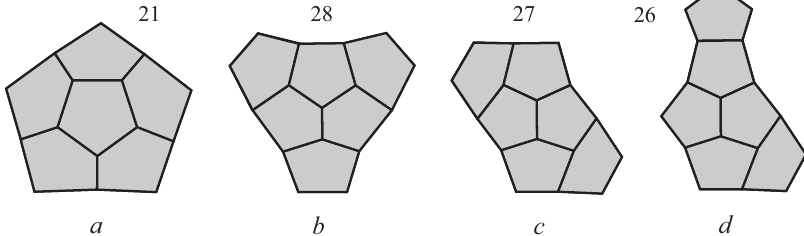
Figure 4. Pentagonal parts of caps for nanotubical fullerene graphs with the maximal Wiener index.